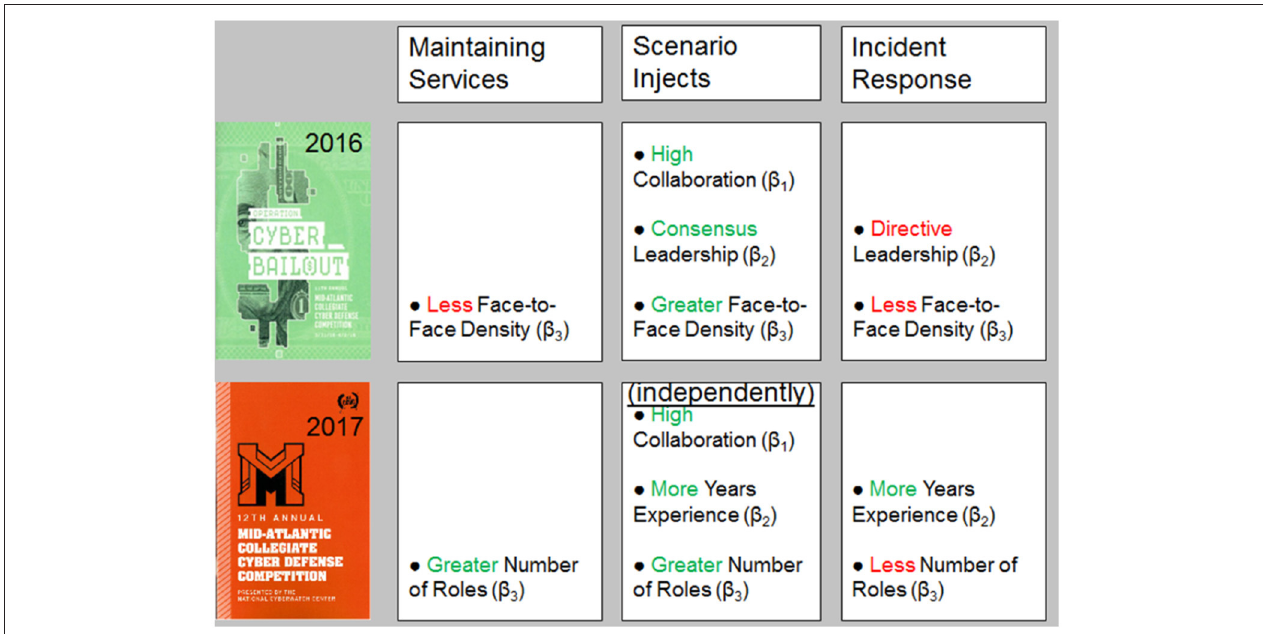
FIGURE 9 | Comparison of Bayesian Multiple Linear Regression Models predictors across the MACCDC 2016 (Top) and MACCDC 2017 (Bottom) events for the scored performance dimensions of (Left) Maintaining Services, (Middle) Scenario Injects, (Right) Incident